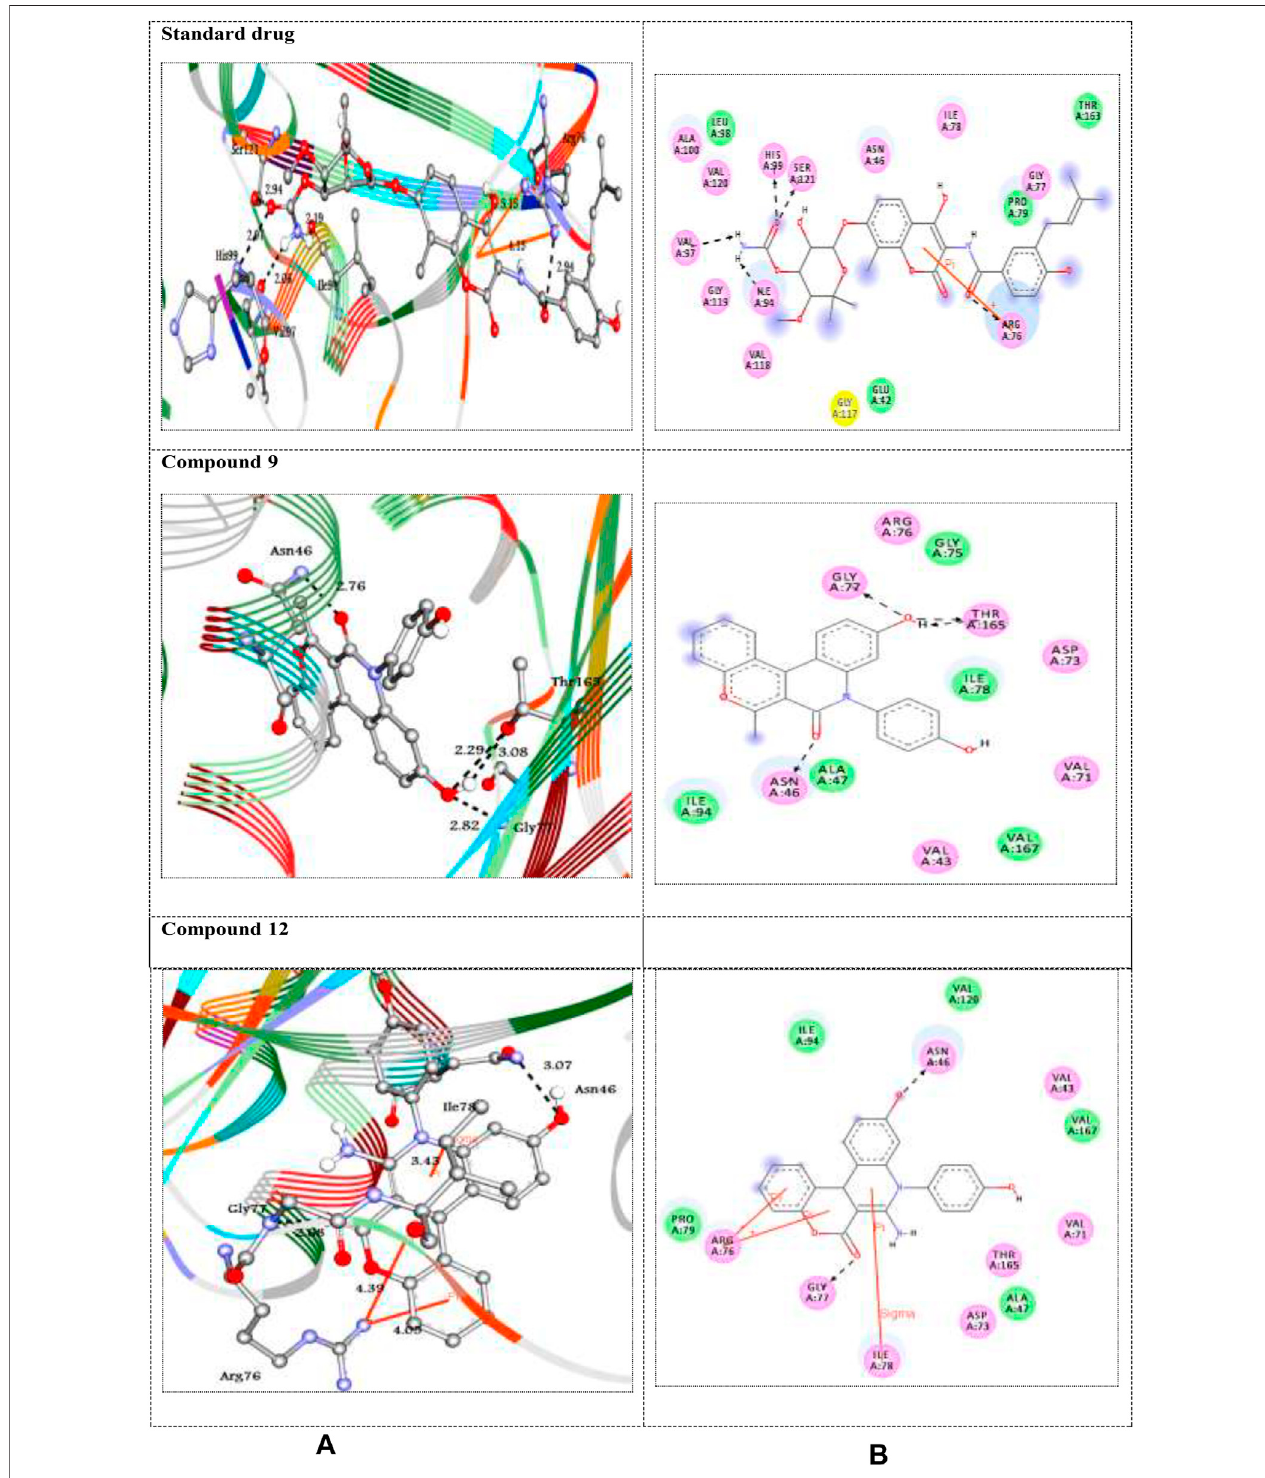
FIGURE 2 | (A) 3D and (B) 2D representations of standard drug and the best docked compounds standard drug with 1JA6. H-bonds are represented in black dotted lines while pi-interactions are shown in orange lines. Colored balls with 3-letter code represented the amino acid residues of the target 1JA6.